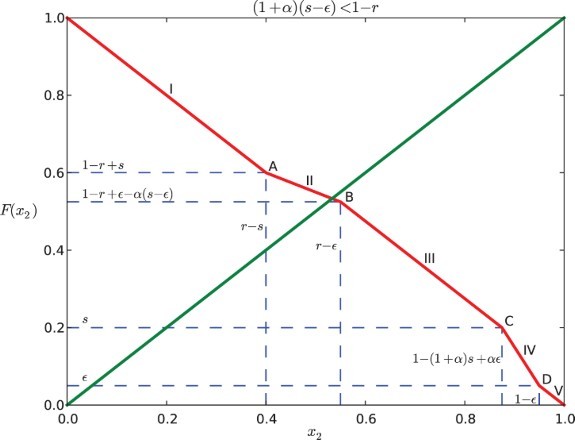
Return map F for Case I when α=−0.5, s=0.2, r=0.6, and ε=0.05.